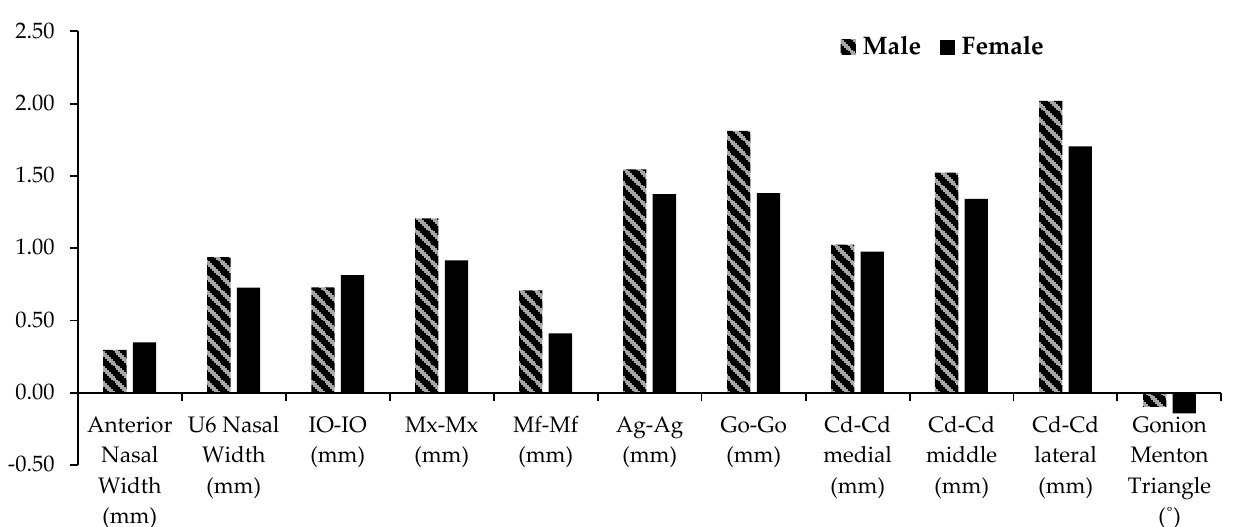
Figure 5. Skeletal transverse changes per year in the non-tooth-bearing regions of the maxilla and mandible for Males (stripes) and females (solid).